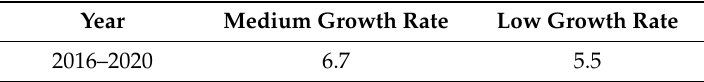
Table 4. Economic growth rates of Beijing form 2016 to 2020